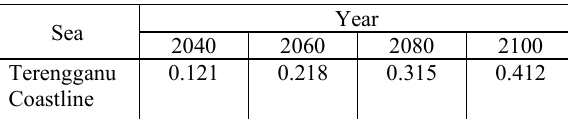
Table 3. The average of sea level rise projection (in m) along the Terengganu